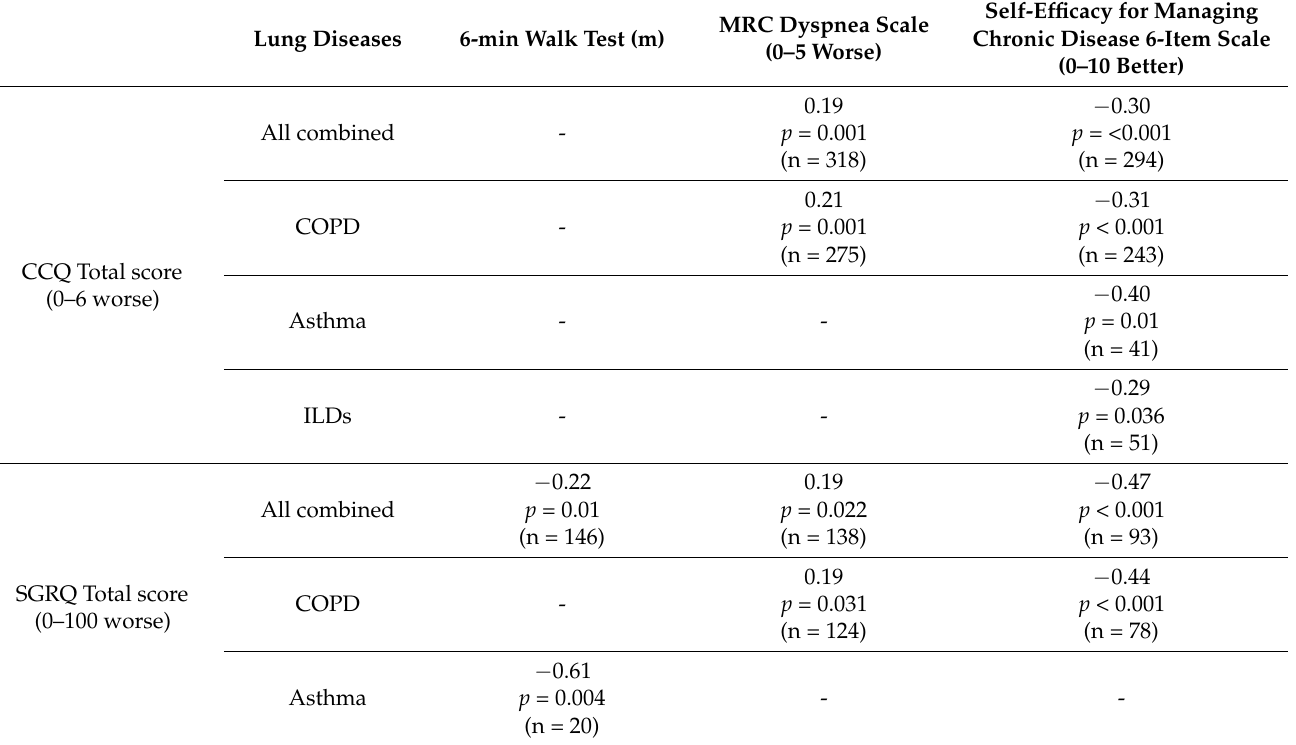
Table 3. Correlation of changes in 6-min walk test, dyspnea, and self-efficacy, with change in health- related quality of life, with regards to lung